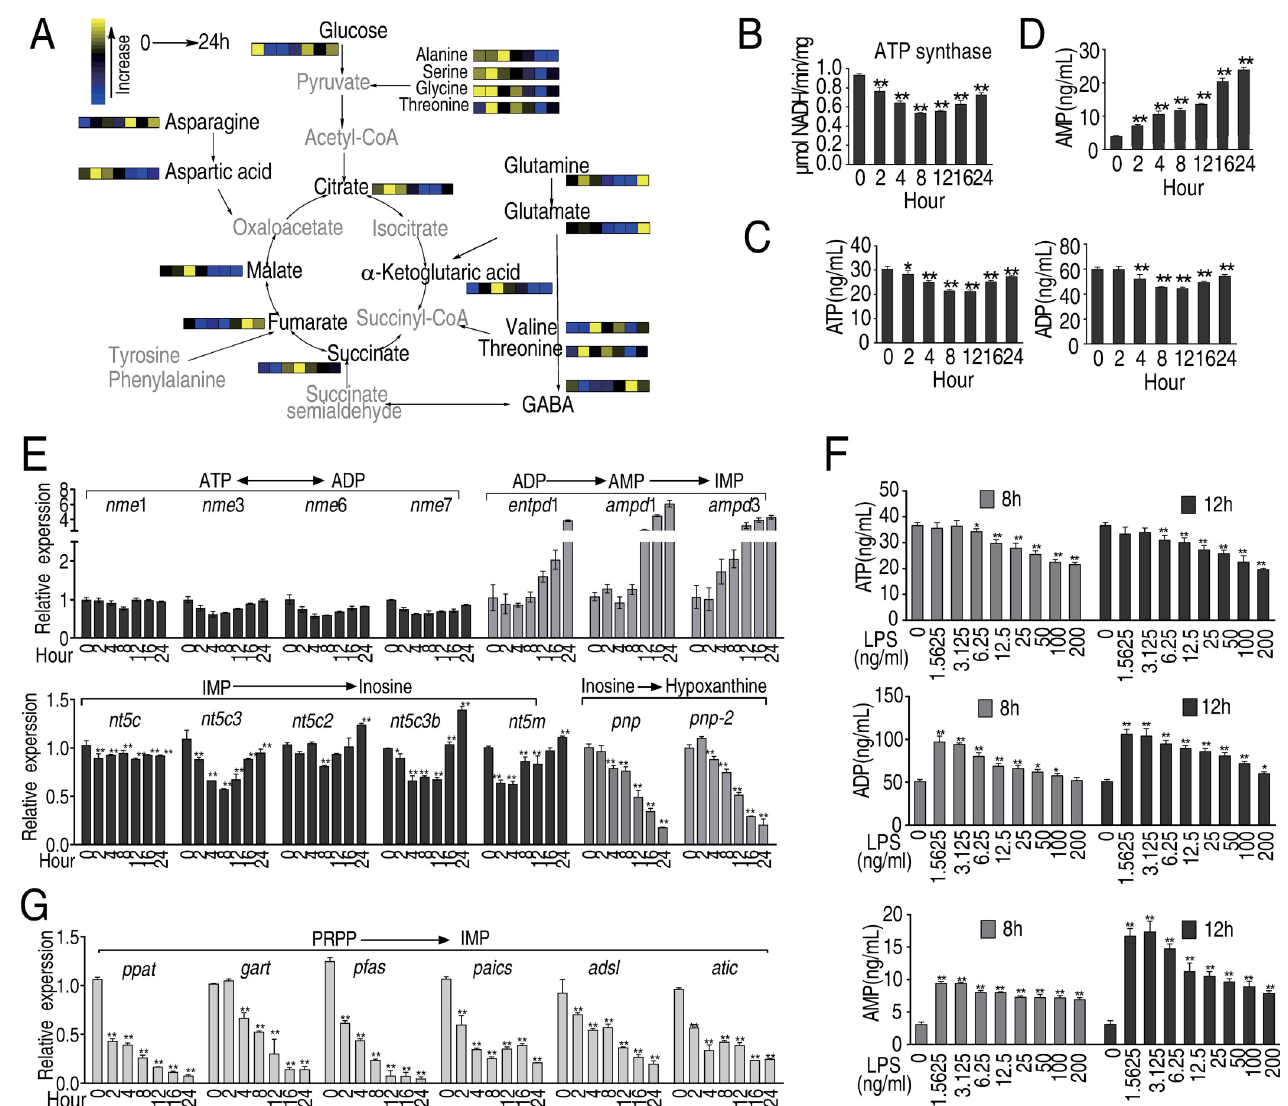
Fig 5. Purine metabolites in LPS-treated macrophages. A, Summary of the abundance of TCA cycle and purine metabolites at the indicated time points after LPS stimulation, based on data (Fig 2A), B, Quantification of ATP synthase activity at the indicated time points in LPS-treated macrophages C, Quantification of ATP and ADP at the indicated time points after LPS stimulation. D, Abundance of AMP at the indicated time points in LPS-treated macrophages. E, Transcription of genes in the ATP salvage pathway in LPS-treated macrophages F, Quantification of ATP, ADP and AMP at 8 and 12 h after exposure to the indicated concentration of LPS. G. Transcripts of genes involved in de novo ATP synthesis were quantified by PCR. Results (B-G) are displayed as mean ± SEM, and significant differences are identified ( � p < 0.05, �� p < 0.01) as determined by non-parametric Kruskal-Wallis one-way analysis with Dunn multiple comparison post hoc test for